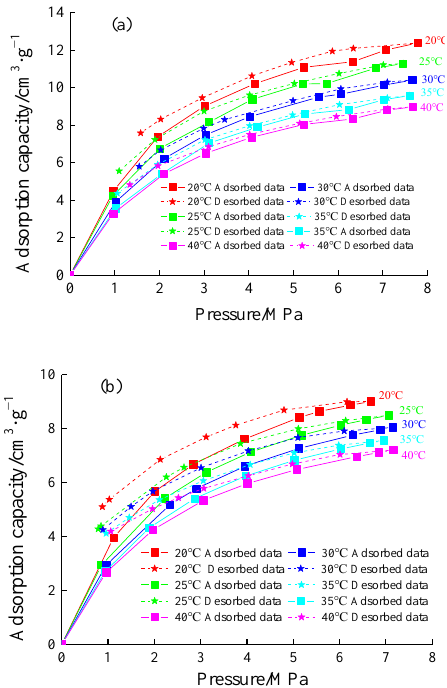
Figure 4. Methane adsorption/desorption curves: ( a ) vitrain; ( b ) durain.